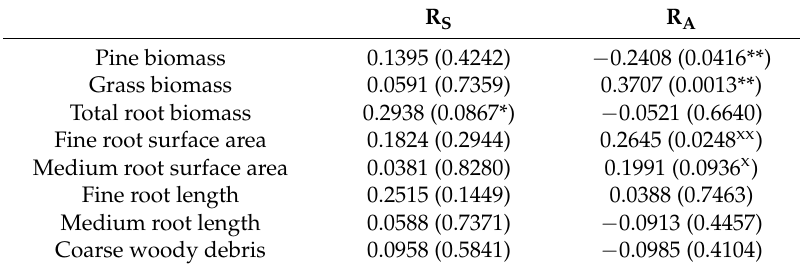
Table 5. Spearman’s correlation coefficients ( r , left) and p -values (in parentheses, right) between root parameters at 0–35 cm soil depth and total R S 1 and proportion of autotrophic respiration to R S (R A ) 2 in a four-year-old switchgrass and loblolly pine agroforestry system on the lower coastal plain of North Carolina. R S R A Pine